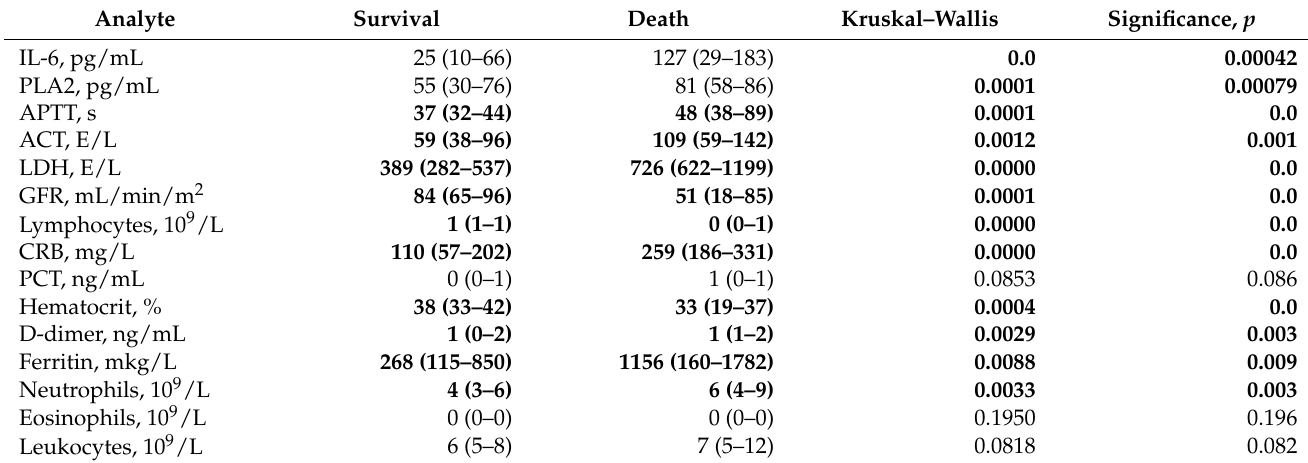
Table 7. Analysis of laboratory analytes depending on the outcome of the disease.